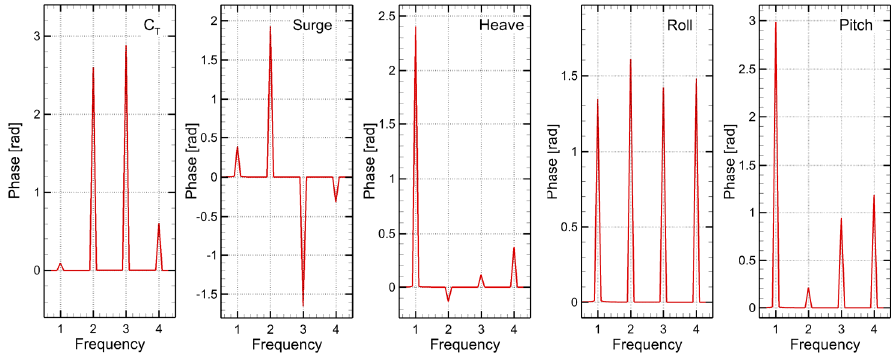
Figure 10. Harmonic phases of the total resistance coefficient ( C T ) , surge ( x ) , heave ( z ) , roll ( ϕ ) , and pitch ( θ ) for the head waves FRxz ϕθ scenario.